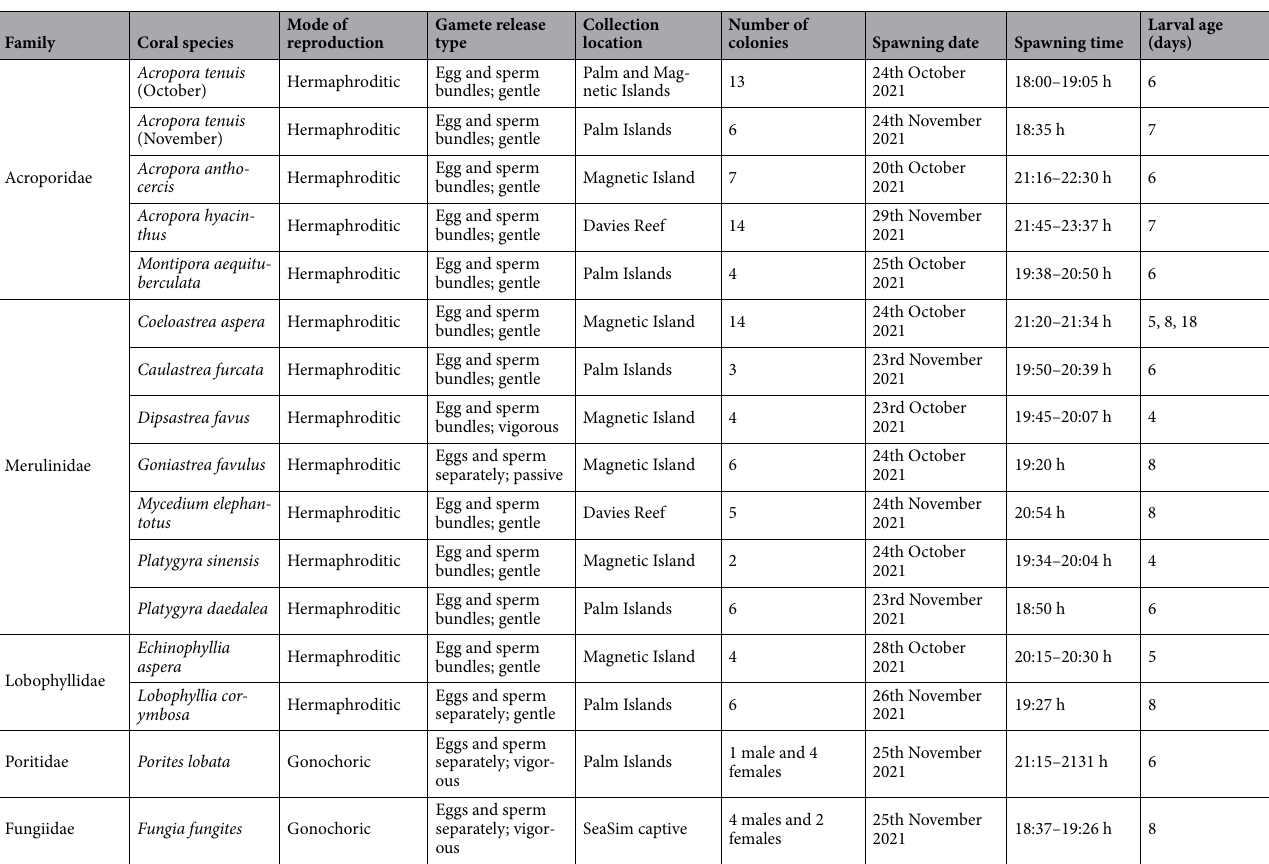
Table 1. Collection, modes of reproduction, spawning details, and the age of larvae at the start of the experiment for the 15 coral species used in the study. The full moon was on the 21st of October (00:56 h) and 19th of November 2021 (18:57 h) during the respective spawning